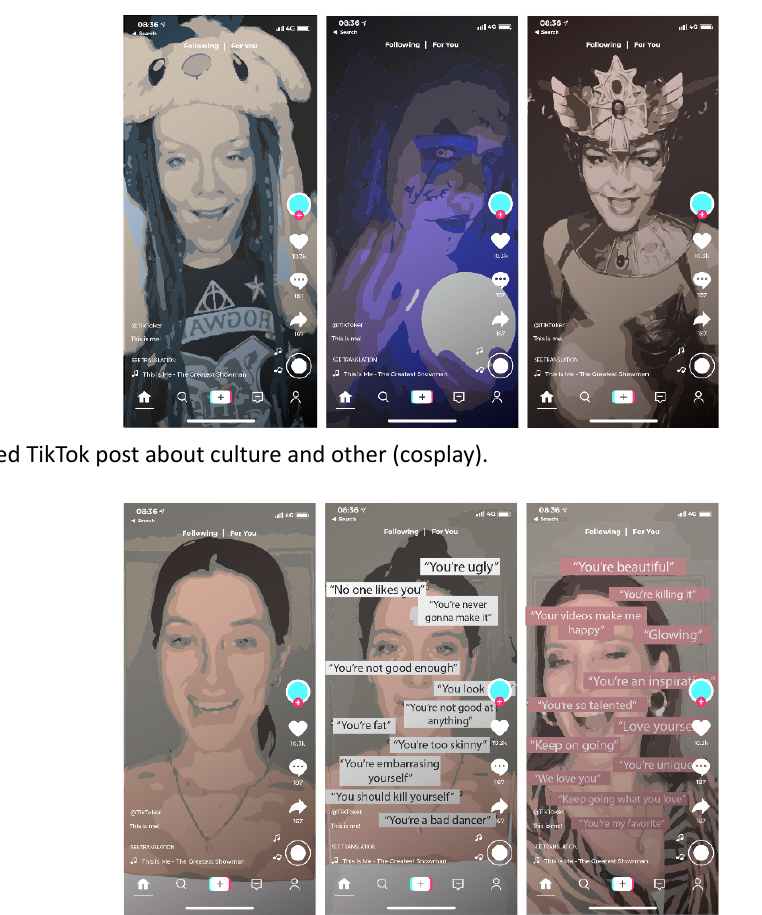
Figure 12. Illustrated TikTok post about other and